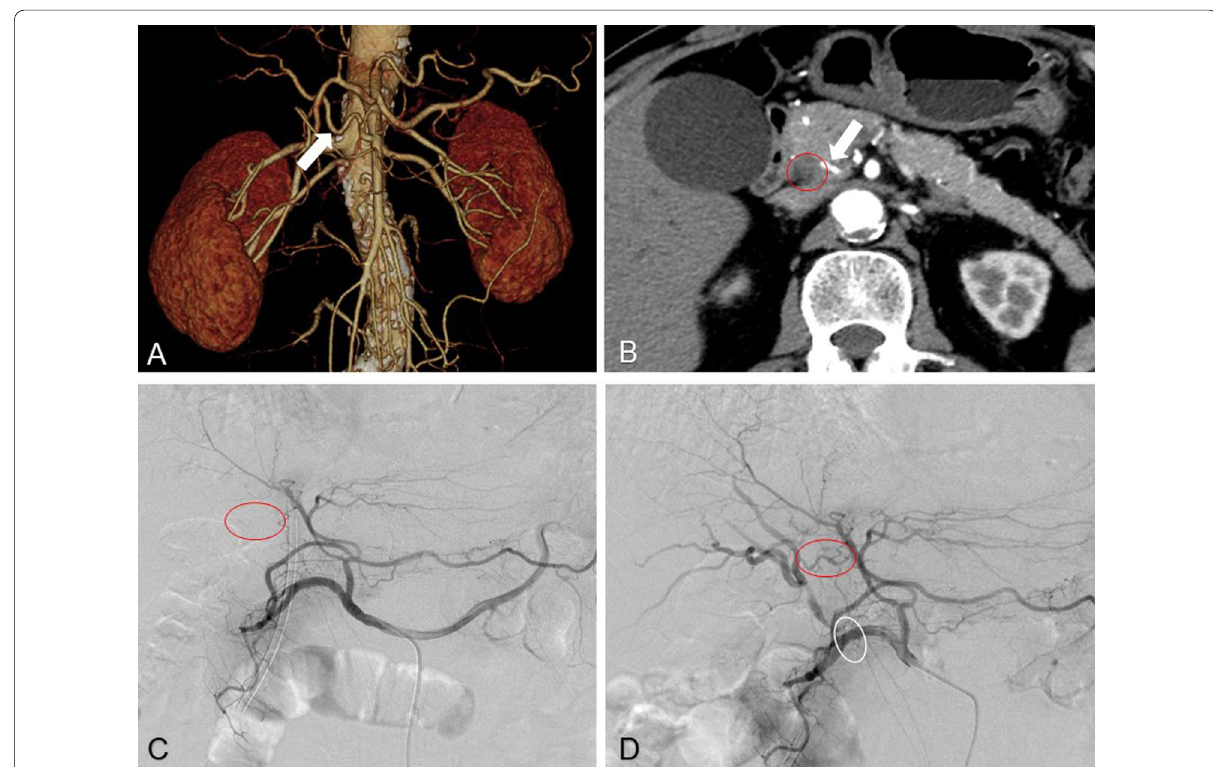
Fig. 1 Case 4: Imaging findings of a representative case of preoperative embolization of rRHA. A rRHA arising from SMA by CT angiography (white arrow). B CT scan showed the main tumor of pancreatic head cancer (red circle) had closely contact with rRHA, which ran into the parenchyma of the pancreas (white arrow). C Before embolization of the rRHA, the vascular supply to the right lobe from the LHA was scanty (red circle). D After embolization of the rRHA by the plug (white circle), blood flow of right lobe of the liver was supplied via the communicating arcade from LHA, which went through the hilar plate (red circle). rRHA replaced right hepatic artery; SMA superior mesenteric artery; CT computed tomography; LHA left hepatic